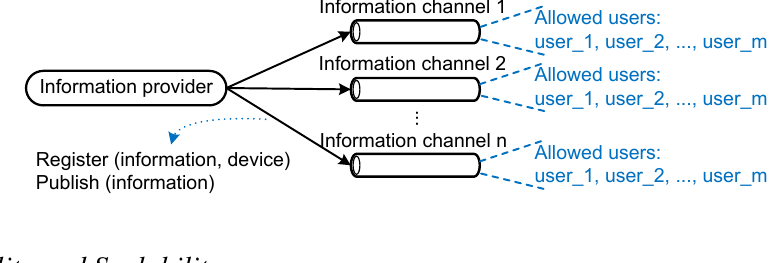
Figure 4. Allowed user lists of information channels belonging to an information